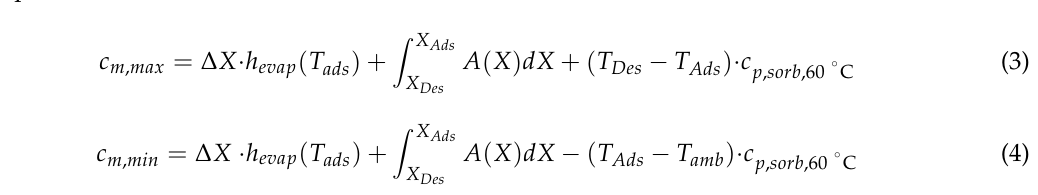
Table 2. Value range for tube diameter and spacing as well as fin thickness and spacing covered during parameter variation.